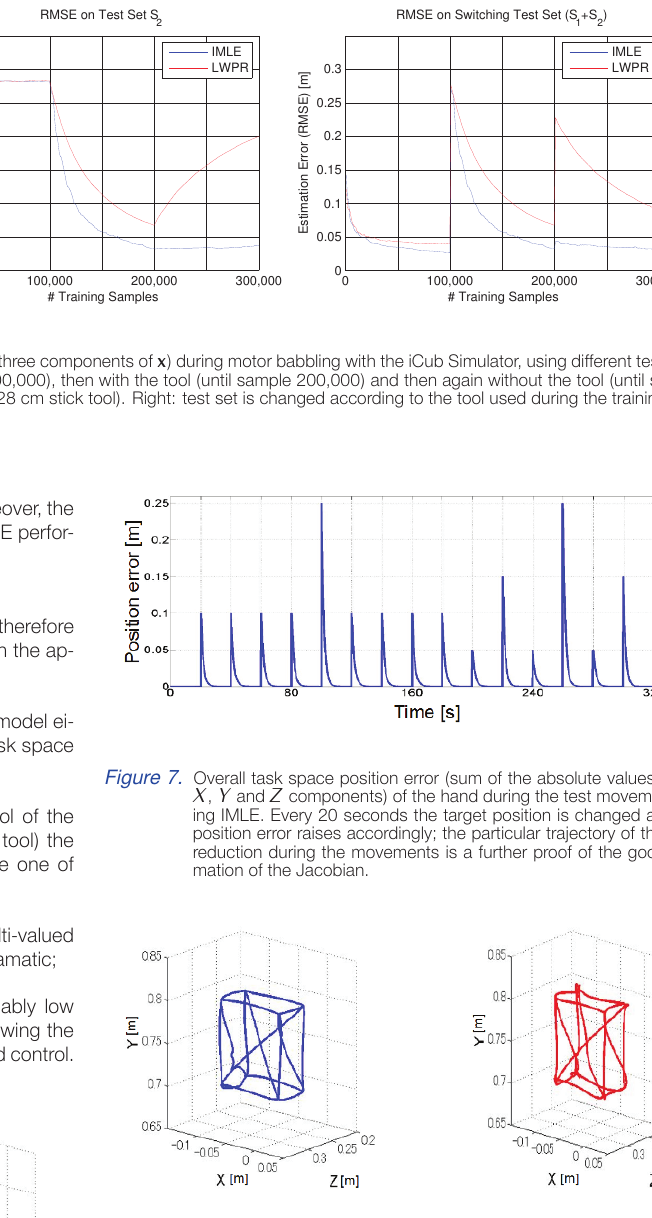
Figure 8. Task space trajectory of the tip of the stick tool during the test move- ment, after motor babbling was performed first without and then with the tool. On the left: using IMLE. On the right: using